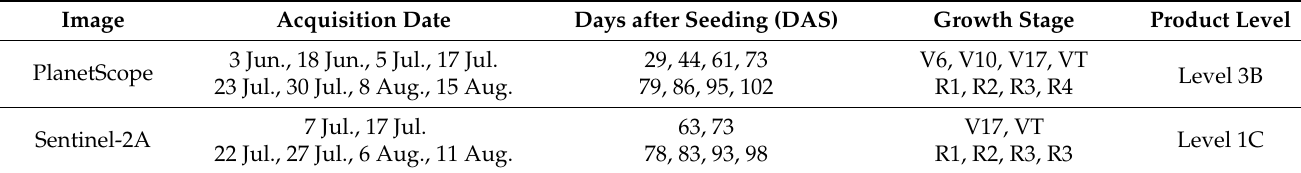
Table 1. Satellite images collected during the corn growing season in